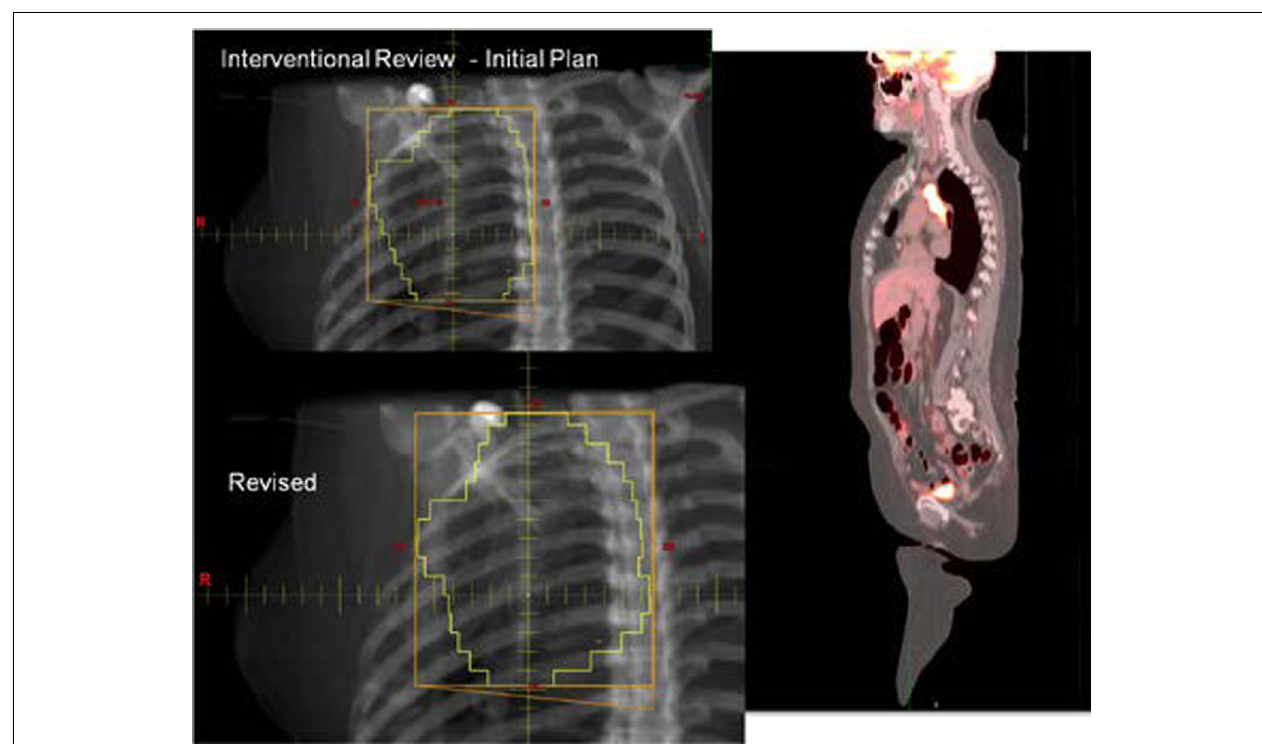
FIGURE 1 | Case submitted for interventional review demonstrating necessary volume revision.